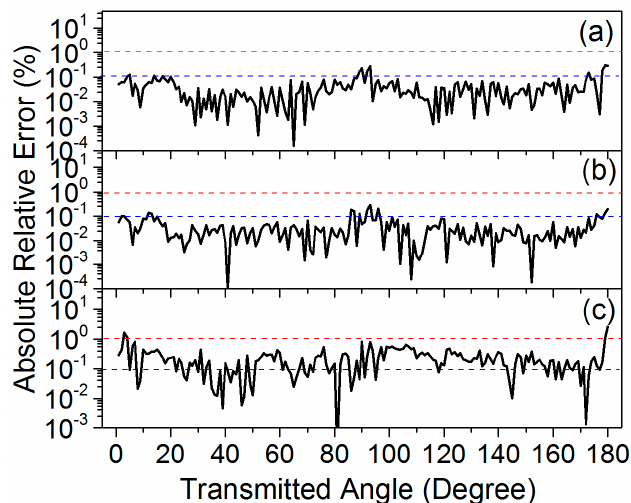
Figure 6. Absolute relative error of Markov chain angular distribution predictions compared to Monte Carlo, with OD discretization scheme 2. Panel ( a ). Phase function 1, OD = 5; Panel ( b ). Phase function 2, OD = 5; Panel ( c ). Phase function 3, OD = 5. Red dash lines indicate an error threshold of 1.0%, and blue dash lines indicate a threshold of 0.1%.